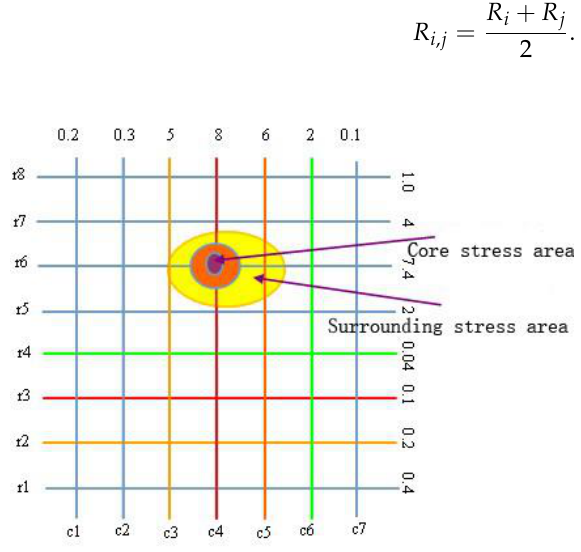
Figure 4. Distribution of loading for CNT yarn.